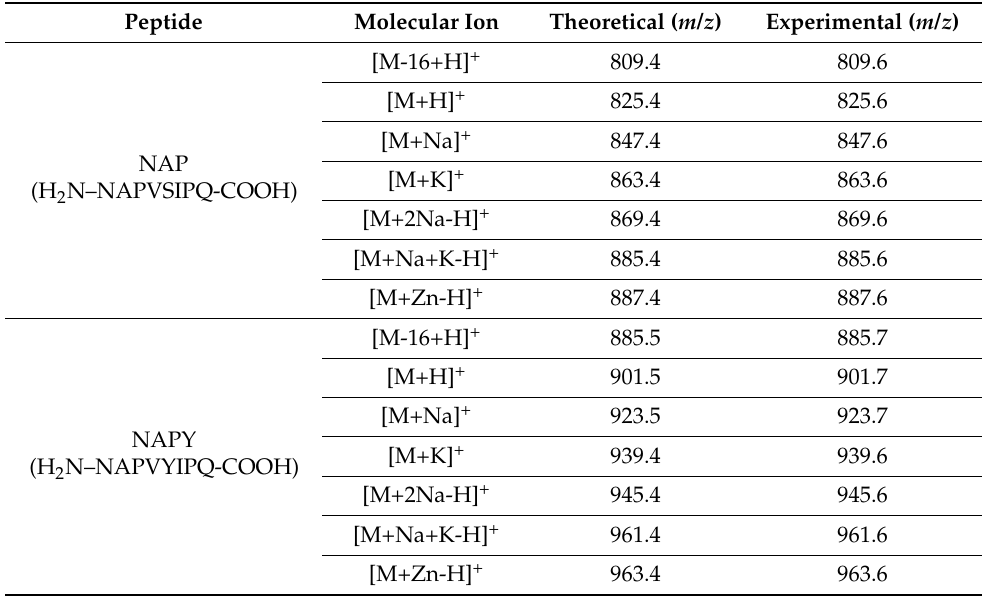
Table 1. The primary structure and molecular weight of the NAP/NAPY peptides in the presence of zinc ions (Zn 2+ ), as experimentally determined with a MALDI-ToF instrument or calculated with ChemCalc online